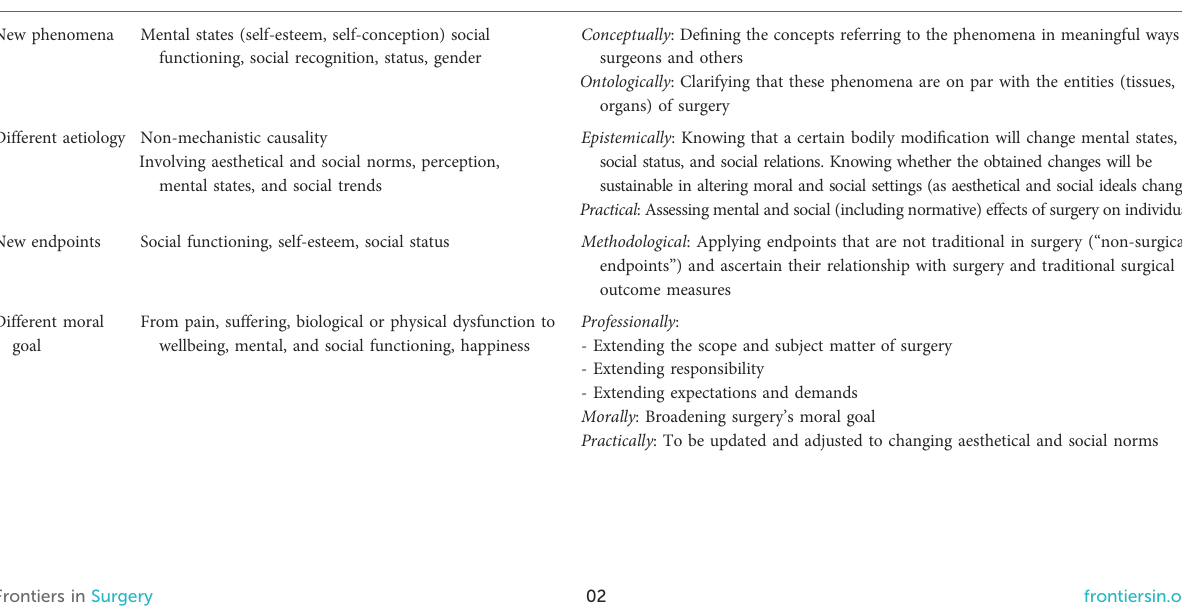
Table 1 Examples of issues and challenges to take into consideration when doing soul surgery and social